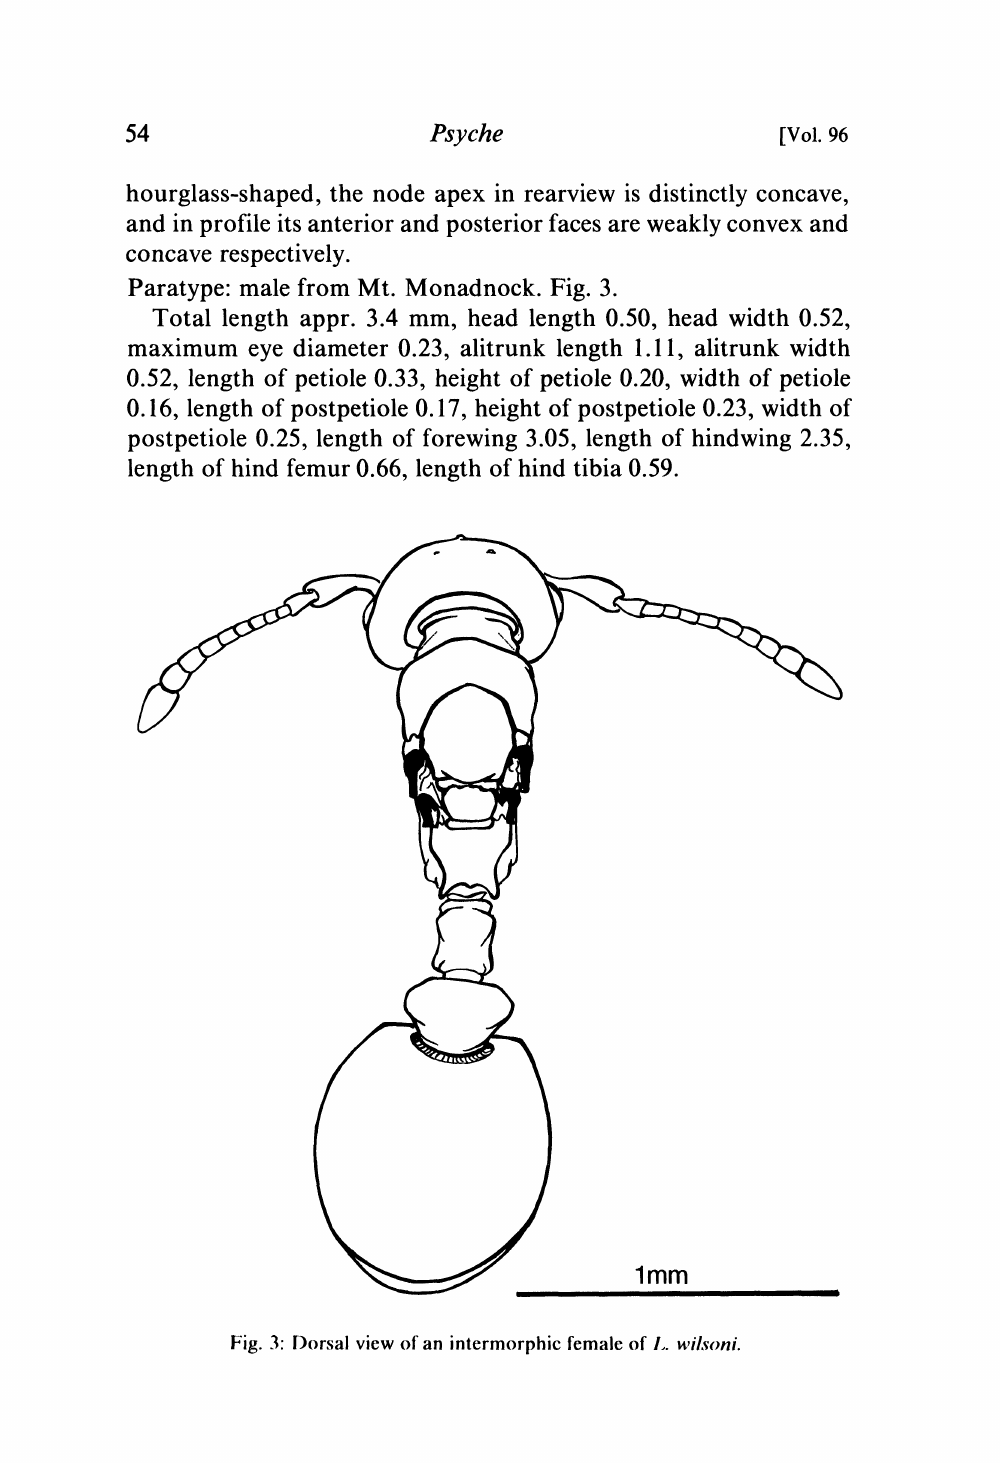
Fig. 3: Dorsal view of an intermorphic female of L.